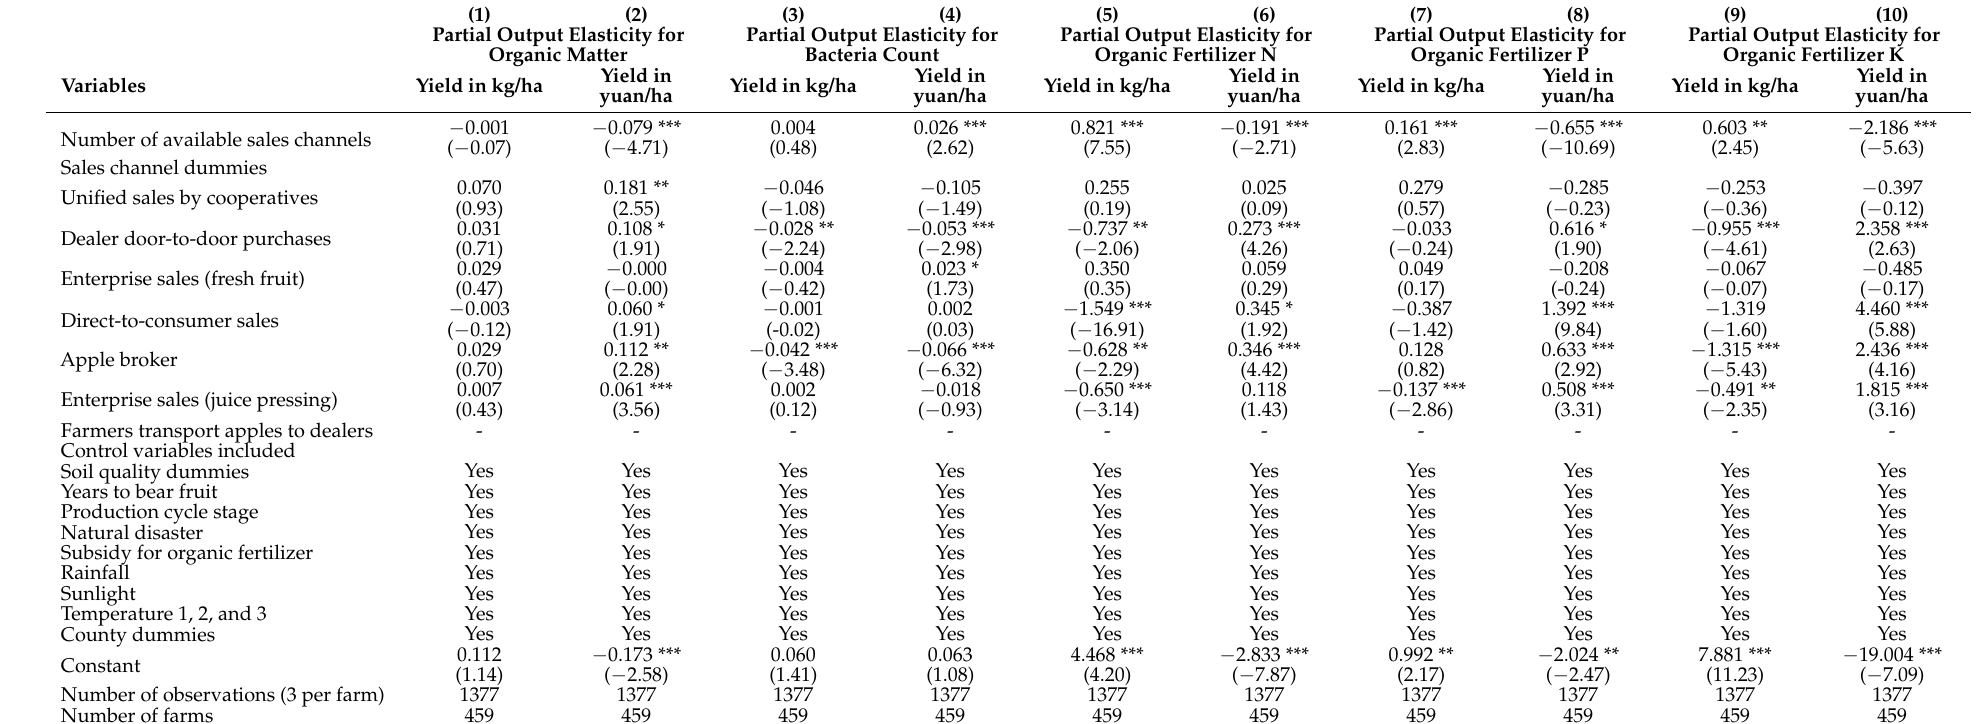
Table 7. Estimated determinants of partial output elasticities for organic